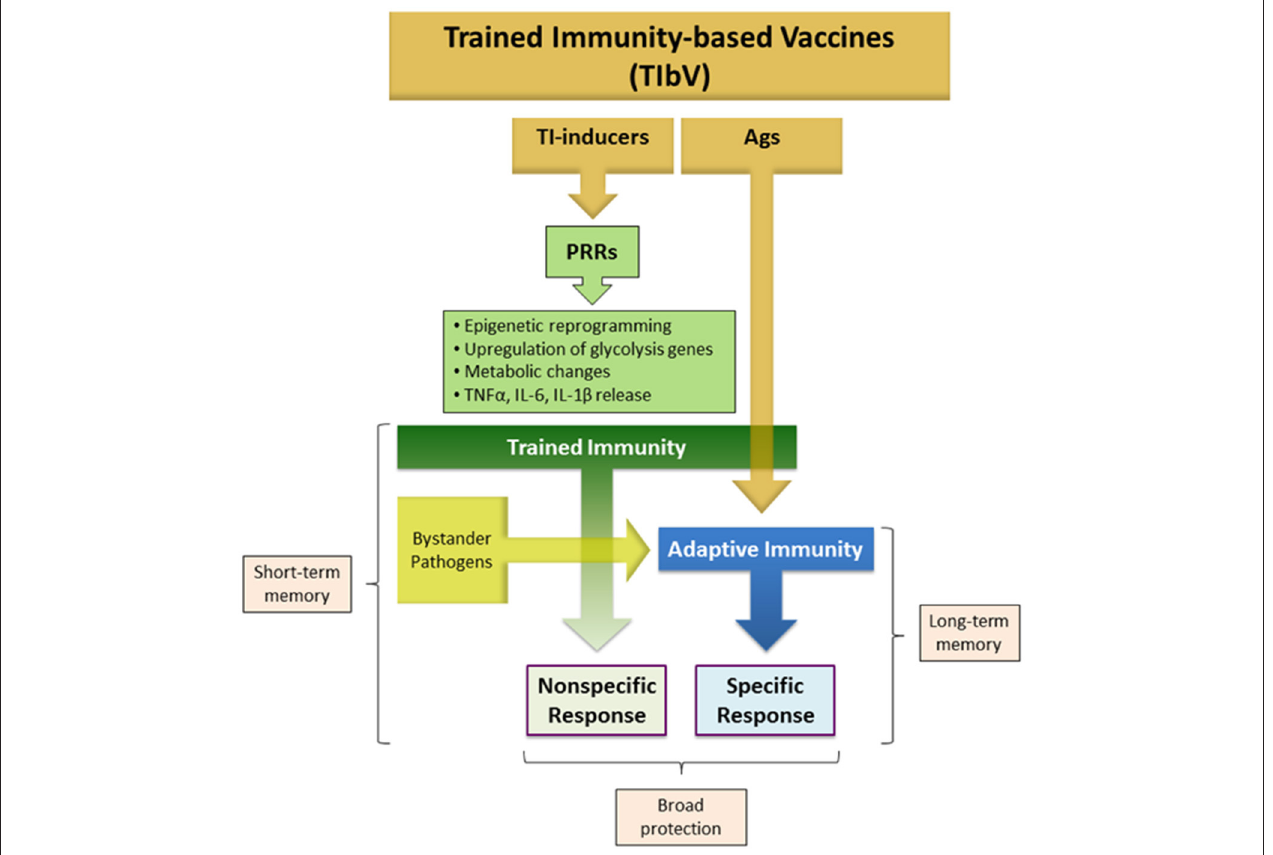
FIGURE 1 | Trained immunity-based vaccine components. TIbV consist of two essential components: (a) Trained immunity (TI) inducers: a range of PAMPs that target a variety of PRRs triggering different signaling pathways that mediate trained immunity. (b) TIbV-related Ags: the antigens associated with the pathogens acting as TI-inducers to which an adaptive immunity is aimed. Thus, TIbV are characterized by conferring Ag-nonspecific resistance directly dependent on trained immunity stimulation plus an Ag-specific resistance dependent on adaptive immunity against the TIbV components and eventual bystander pathogens. PAMP, pathogen-associated molecular pattern; PRR, pattern recognition receptor; Ag, antigen.